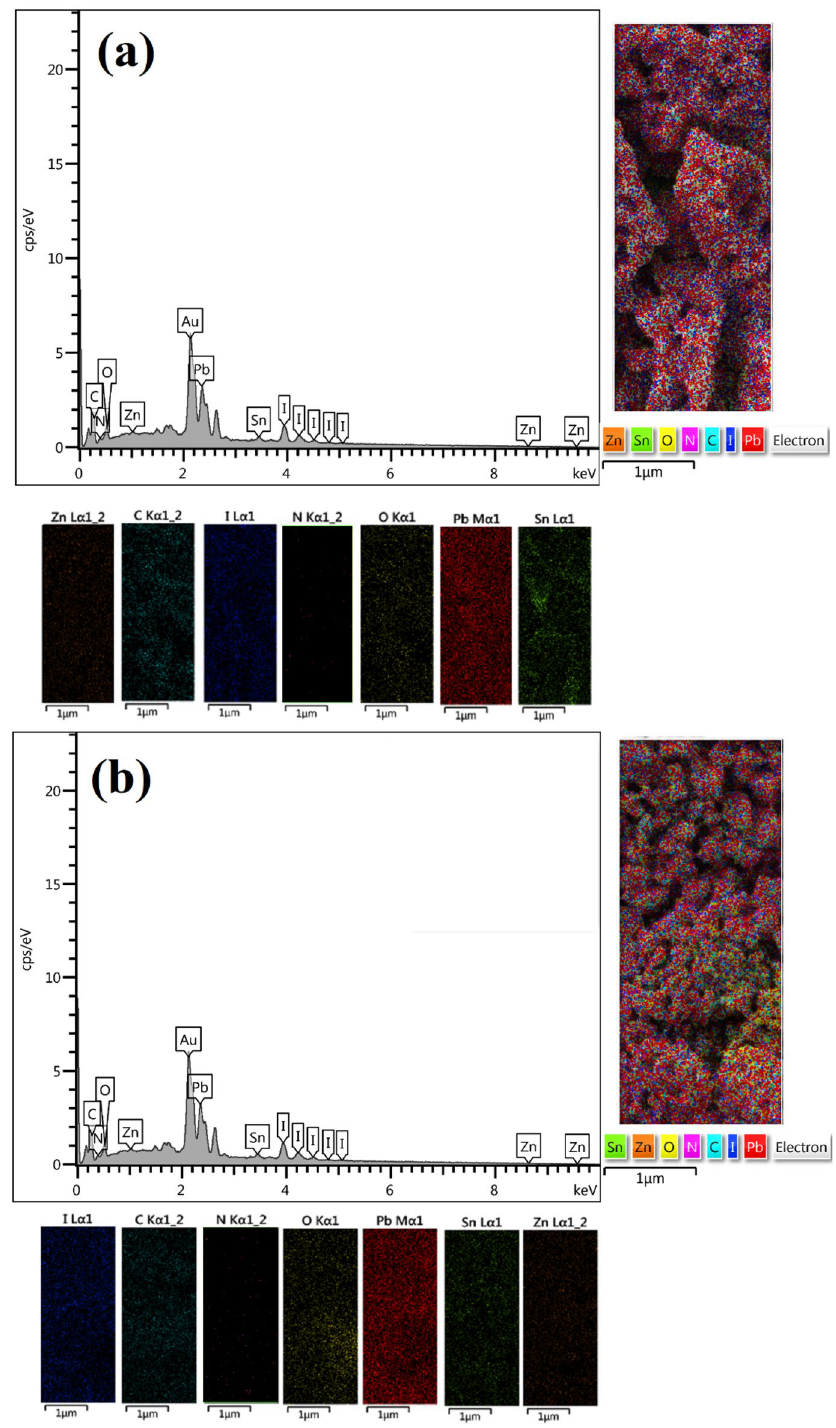
Figure 6. The EDX spectra and the mapping analysis for perovskite films spin-coated on ( a ) SnO 2 @ZnO nanocomposite, and ( b ) SnO 2 @ZnO.PANI 4%